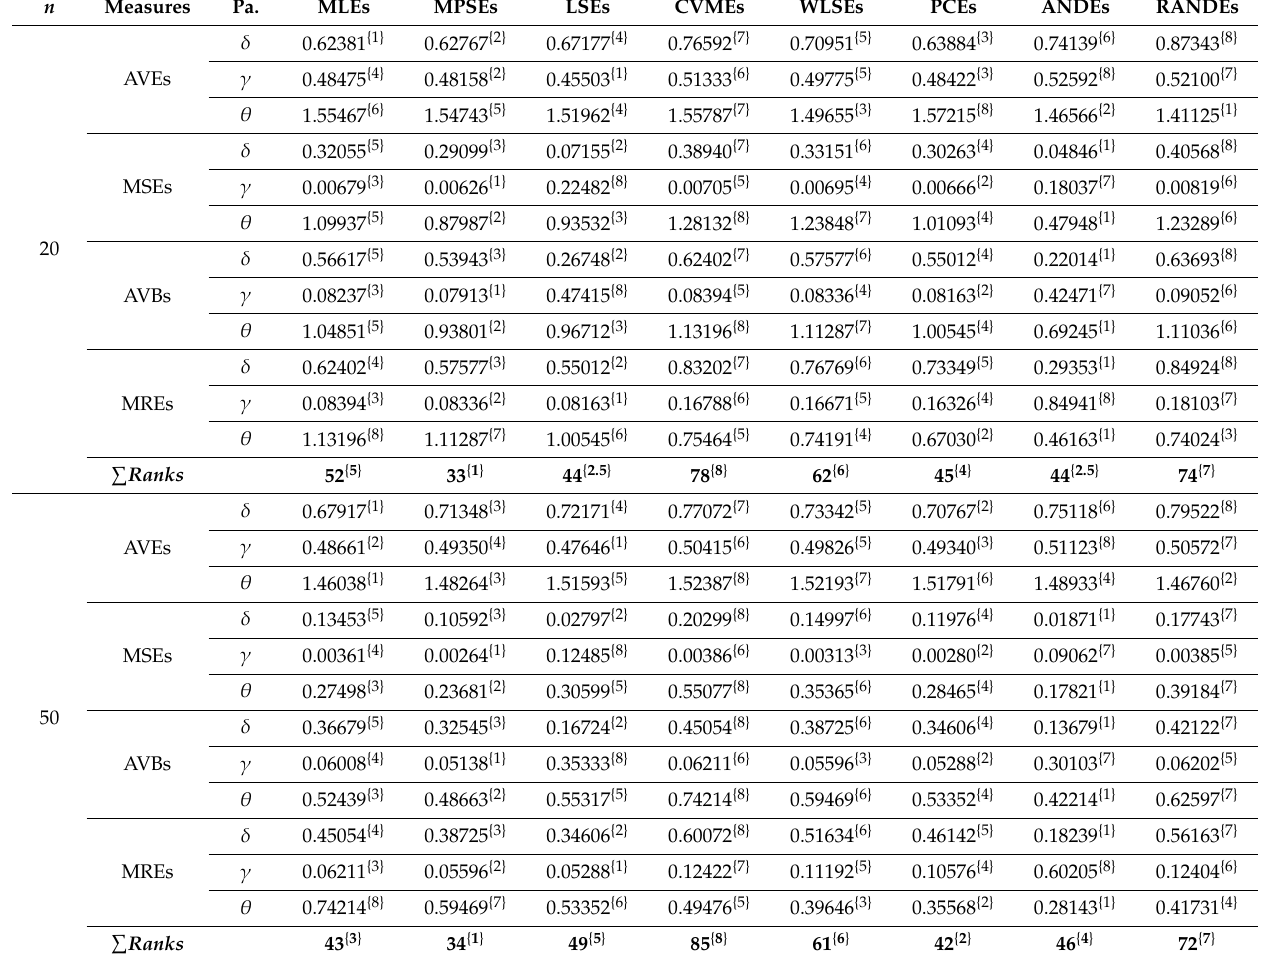
Table A2. Simulation results of several estimation methods for δ = 0.75, γ = 0.50 and θ =